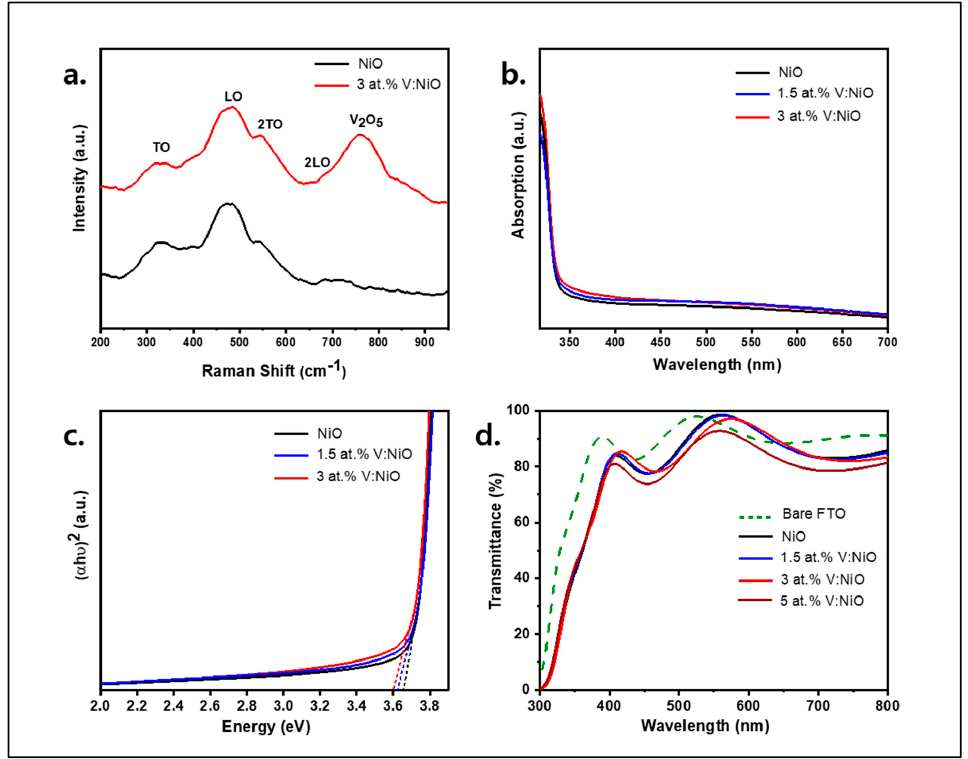
Figure 3. ( a ) Raman spectra of NiO and 3 at.%V:NiO NP powder samples; ( b ) UV-absorption spectra of diluted NiO and V:NiO NP solutions with di ff erent atomic percentages of V; ( c ) Corresponding Tauc plots of the absorption spectra; ( d ) Optical transmission spectra of NiO and V:NiO films with di ff erent atomic percentages of